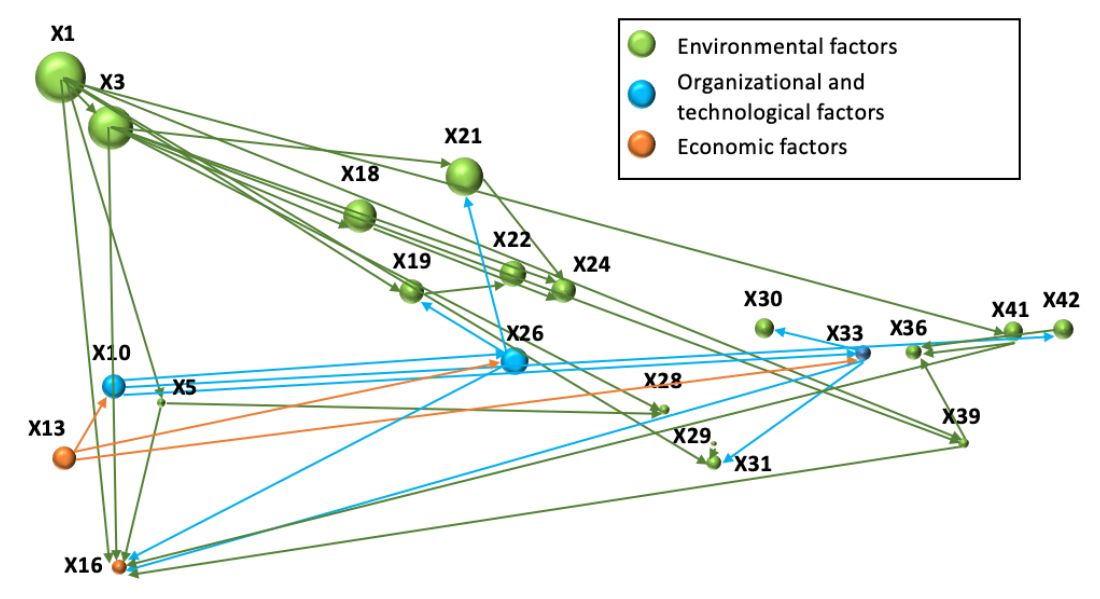
Figure 4. Interrelations between factors affecting the environmental and economic appraisal of energy projects.